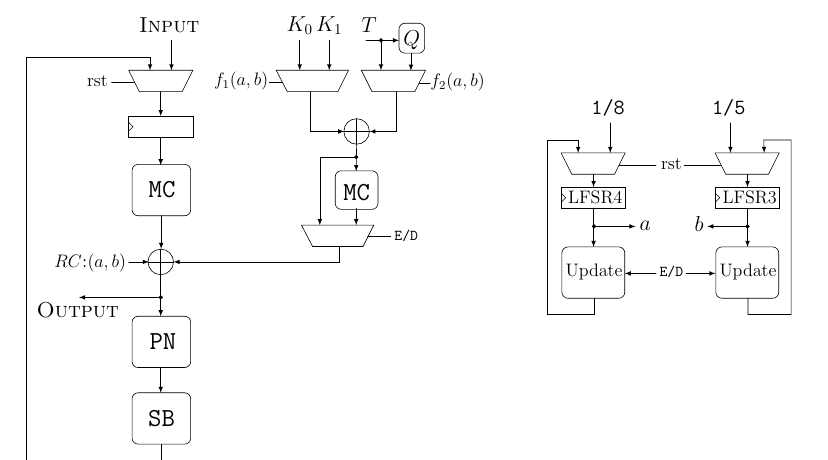
Figure 8: Round-based design architecture of CRAFT supporting tweak, encryption and